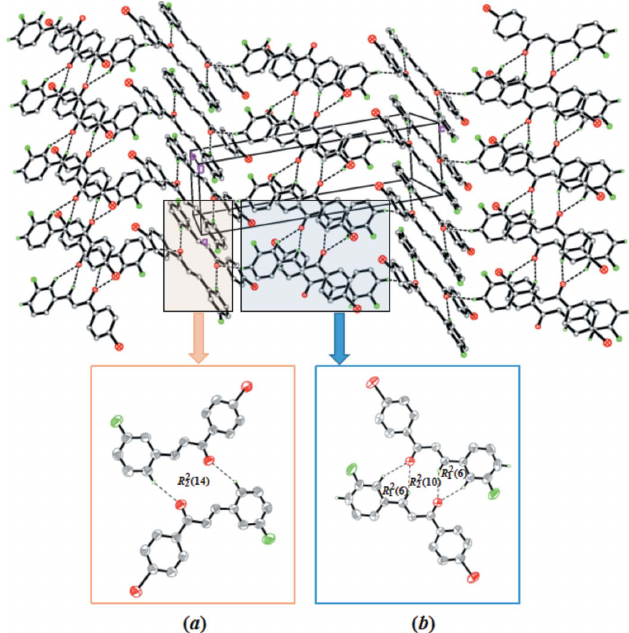
Figure 1 ( a ) The molecular structure of the title compound with displacement ellipsoids drawn at the 50% probability level and ( b ) the optimized molecular structure of the title compound generated using the DFT method at the B3LYP/6–311 G++(d,p) level.